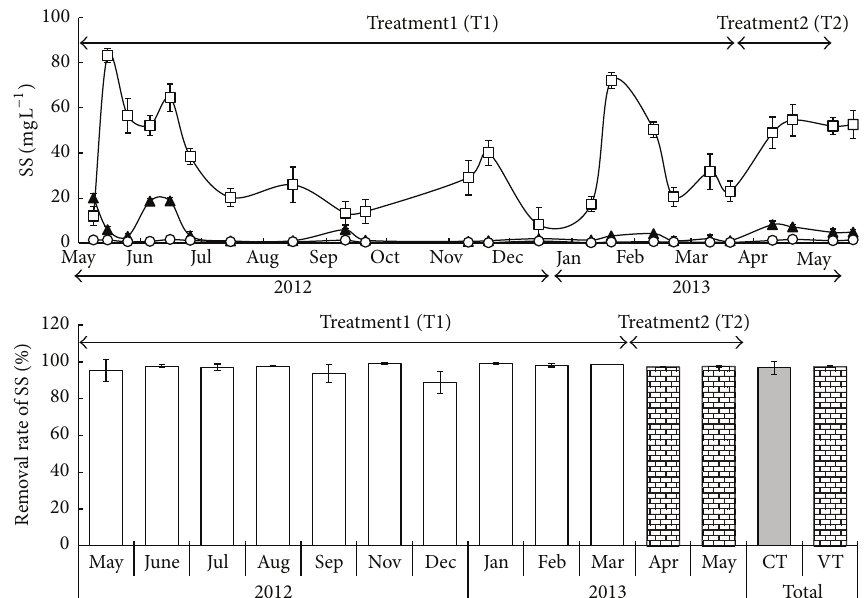
Figure 4: The concentration and removal rate of SS in the water with time in a VF-HF hybrid constructed wetland under different ventilation methods ( ◻ : inflow; 󳵳 : 1st treatment; I : 1st + 2nd treatment; Treatment1 (T1): VF-HF CWs with natural ventilation; Treatment2 (T2): VF-HF CWs with ventilation using an electric air fan